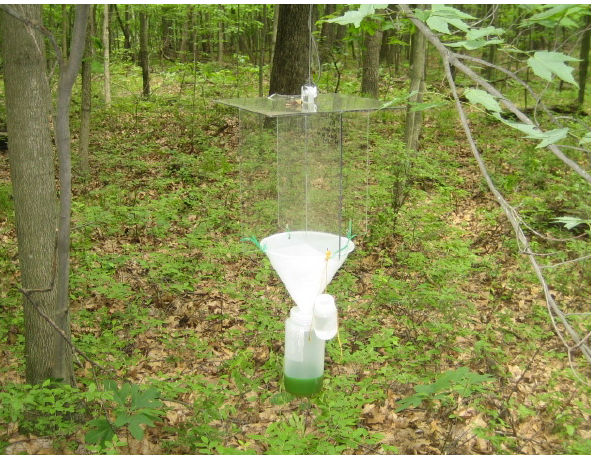
Figure 2. Lindgren Funnel trap used for capturing Cerambycid beetles.